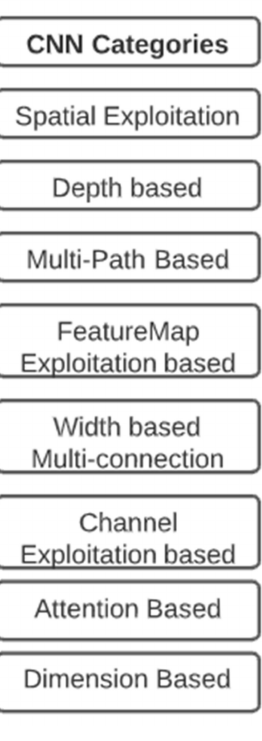
Figure 12. CNN variants